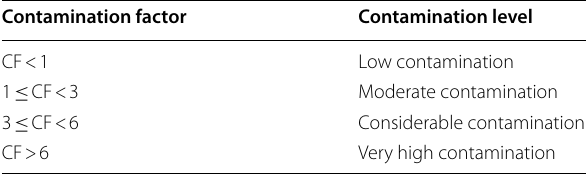
Table 3 Classification of contamination